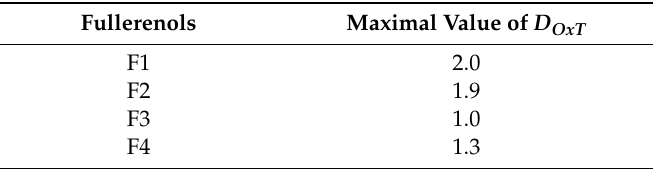
Table 4. Maximal values of D OxT of fullerenols (F1–F4) in model solutions of organic oxidizer (1,4-benzoquinone) for the enzymatic assay.